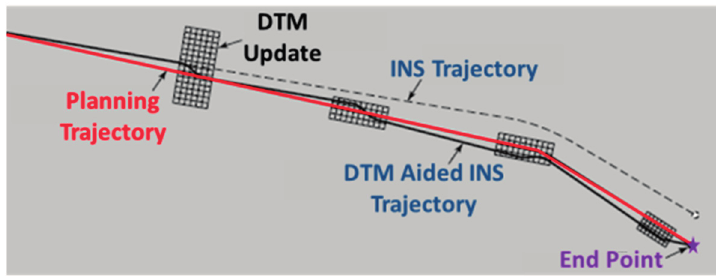
Figure 5. DTM aiding algorithm in